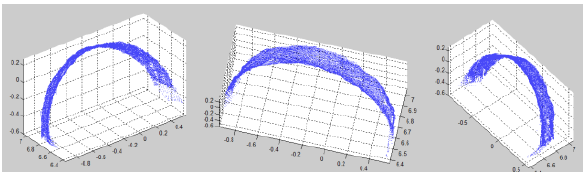
Figure 9: 3D representation of the coordinates list of the